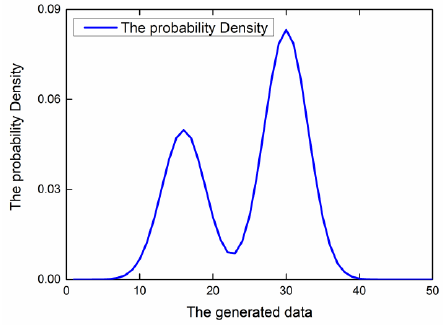
Figure 3. The one-dimensional Gaussian mixture distribution. Figure 3. The one ‐ dimensional Gaussian mixture distribution. Figure 3. The one ‐ dimensional Gaussian mixture distribution. Figure 3. The one ‐ dimensional Gaussian mixture distribution.